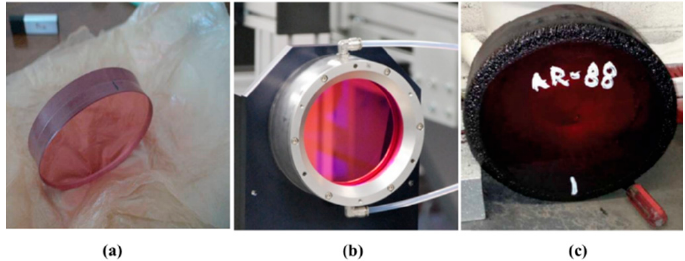
Figure 7. Large size Ti:sapphire crystals. ( a ) 80 mm diameter crystal disk for a PW class laser system. ( b ) 120 mm diameter crystal in a mechanical mount with cooling liquid; ( c ) 275 mm diameter crystal boule to be processed as crystal disk for the final amplifier of the 10-PW class femtosecond laser of extreme light infrastructure-nuclear physics,